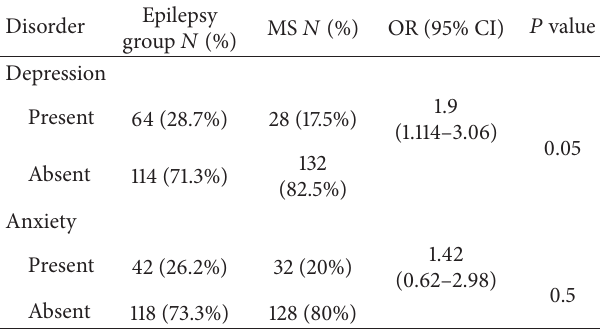
Table 3: Comparative Rates of depression in PWE compared to